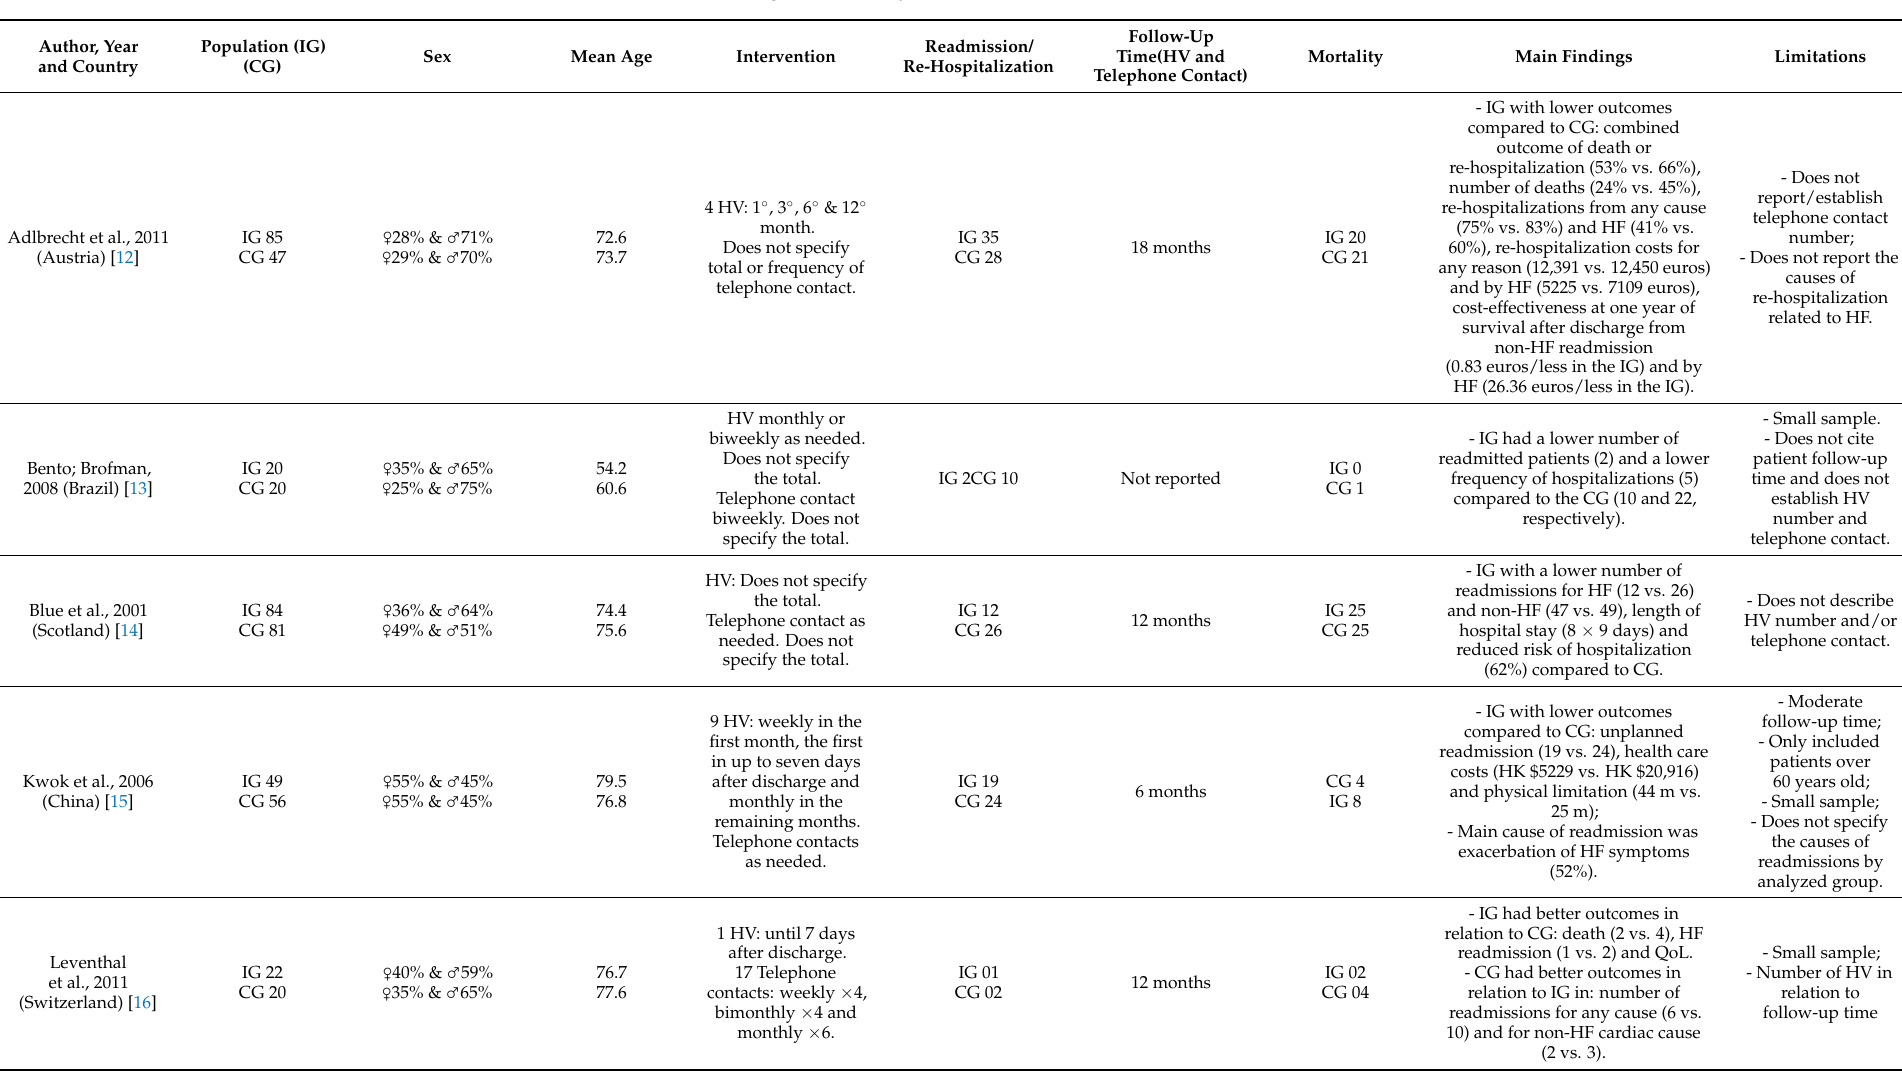
Table 1. Main characteristics of the studies eligible for